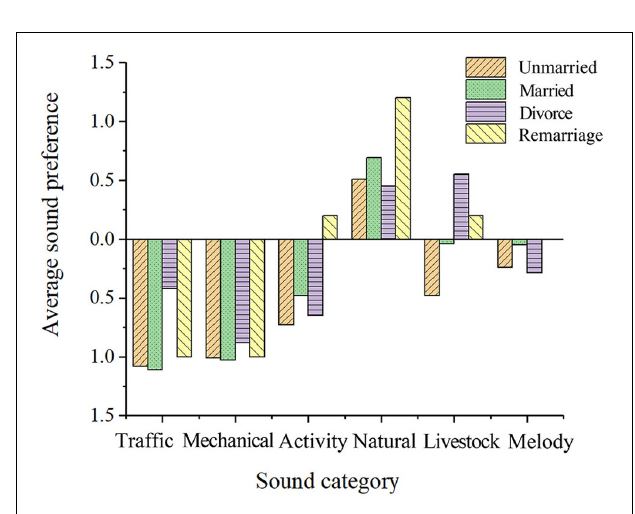
FIGURE 7 | Average soundscape preference of different occupational groups.